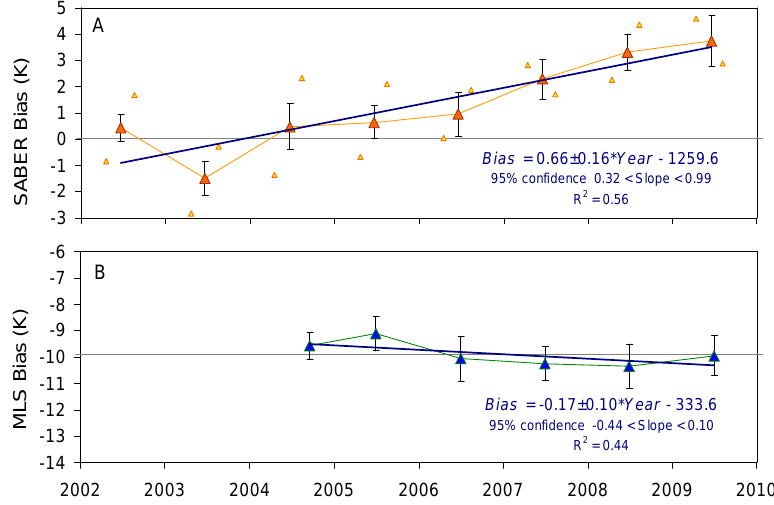
Figure 3. (Panel A) The mean SABER-DavisOH bias for each year, and for each yaw-cycle 2 Fig. 3. (A) The mean SABER-DavisOH bias for each year, and for each yaw-cycle campaign, from Fig. 1c. A straight line fit to the latter shows a trend in the bias of ∼ 0.7K/annum. (B) MLS-DavisOH bias for each year. A straight-line fit to this data is not significantly different campaign, from Fig. 1C. A straight line fit to the latter shows a trend in the bias of 3 from zero trend at the 95% confidence ~0.7 K/annum. (Panel B) MLS-DavisOH bias for each year. A straight-line fit to this data is 4 not significantly different from zero trend at the 95% confidence level. 5